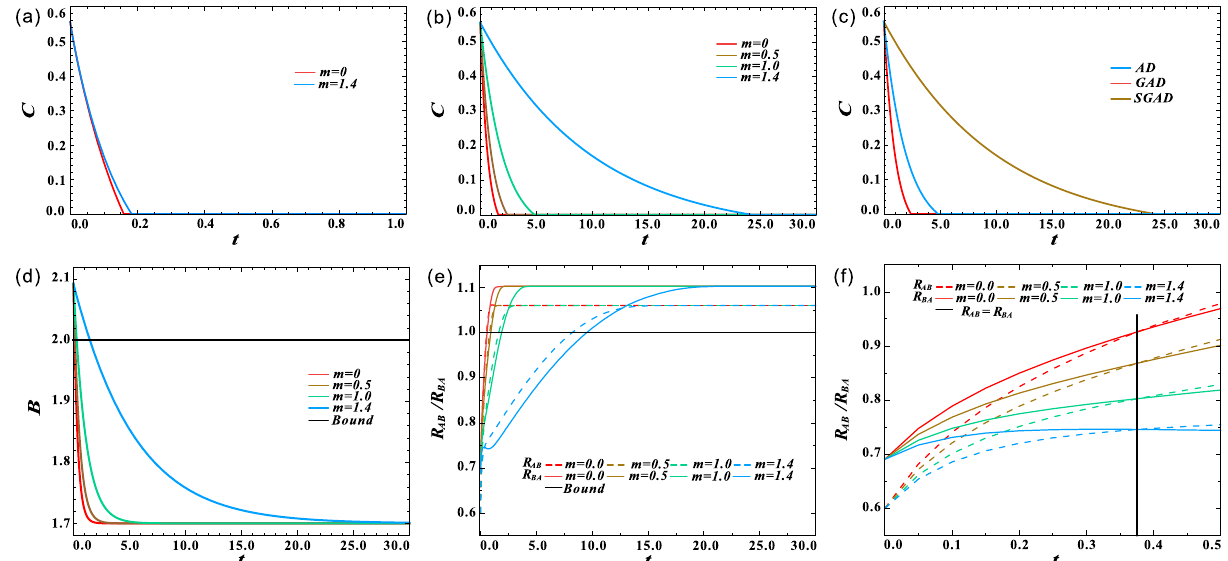
0 . ( b ) Concurrence C as a function = 1, m 1.4, n 1 ) channels. ( d ) Bell = = = 0, 0.5 0.37 , the black line t ∈ [ ] =